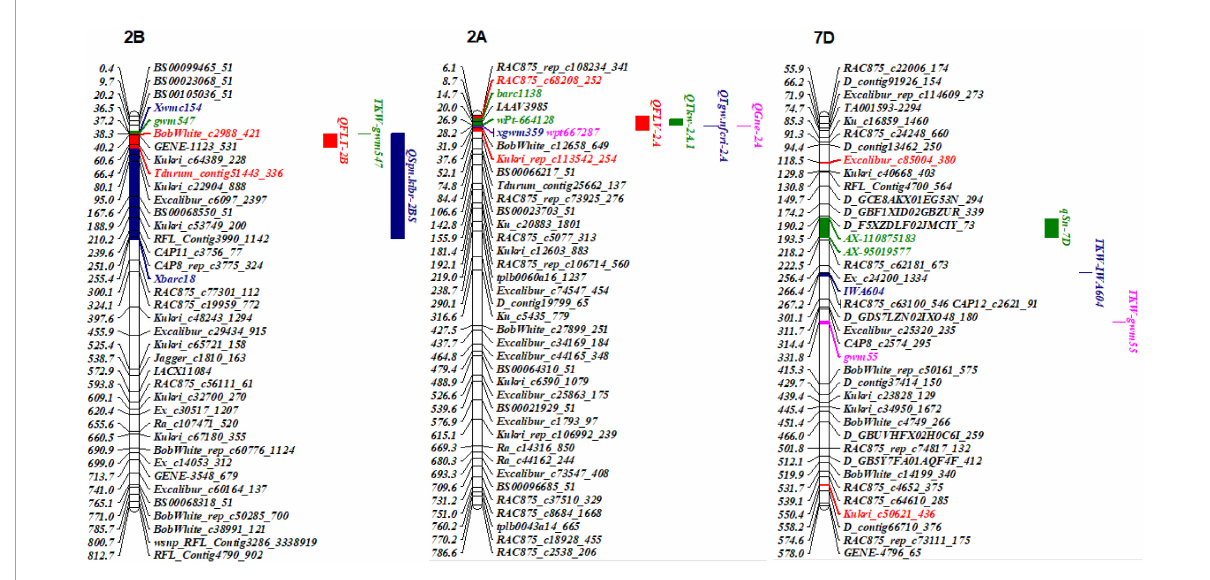
FIGURE5 Physical map of the major QTL QFLT-2B , QFLV-2A , and QFLV-7D